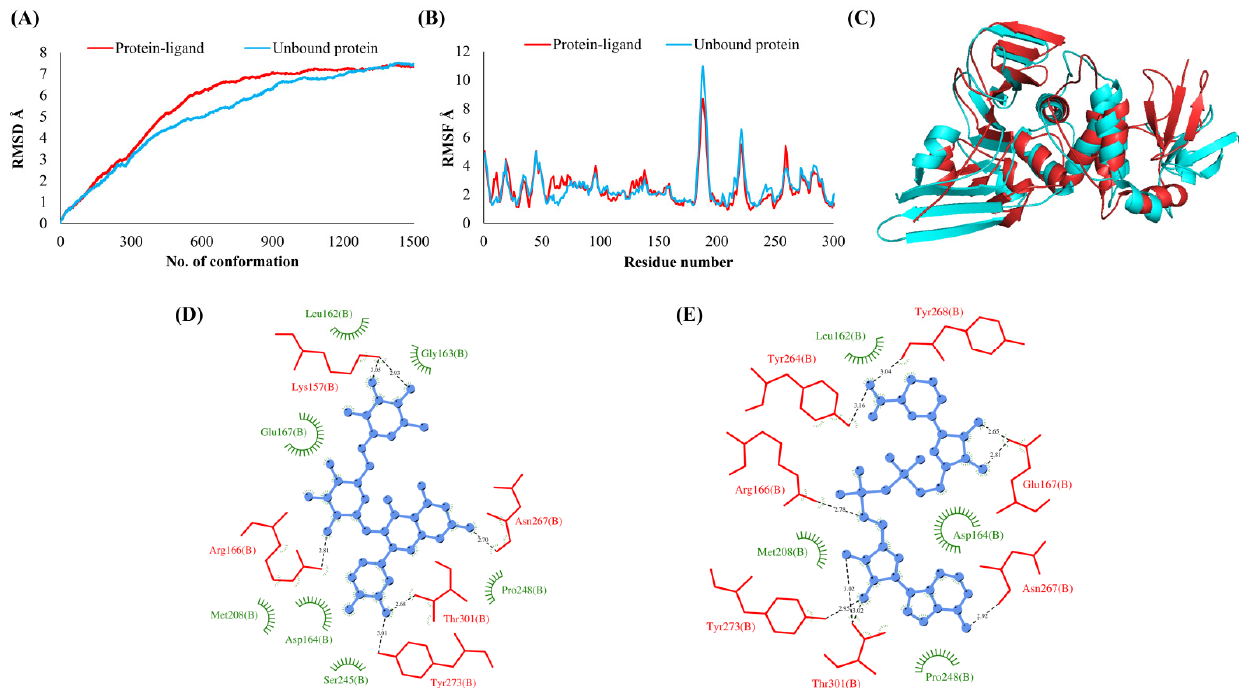
Figure 1. Leader protein (NSP1). ( A ) RMSD plot of unbound and ligand-bound protein ( B ) RMSF plot of unbound and ligand-bound protein ( C ) Superimposition of unbound and ligand-bound protein ( D ) Molecular interactions of protein with Rutin ( E ) Molecular interactions of protein with NADH.